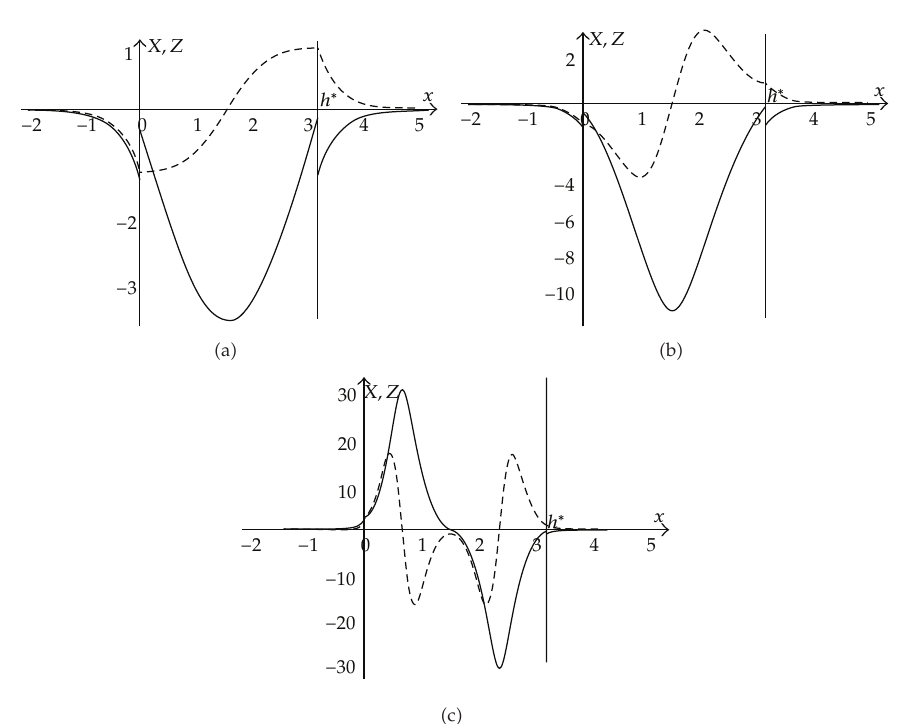
Figure 3: Eigenfunctions (cid:3) fields (cid:4) for the nonlinear problem are shown. Solid curves for X ; dashed curves for Z . The same parameters as in Figure 2 are used. For (cid:3) a (cid:4) , γ (cid:7) 2 . 994; for (cid:3) b (cid:4) , γ (cid:7) 3 . 892: for (cid:3) c (cid:4) , γ (cid:7) 8 . 657, and h (cid:7) 3 . 206 is used for all three cases. The eigenvalues are marked in Figure 2.